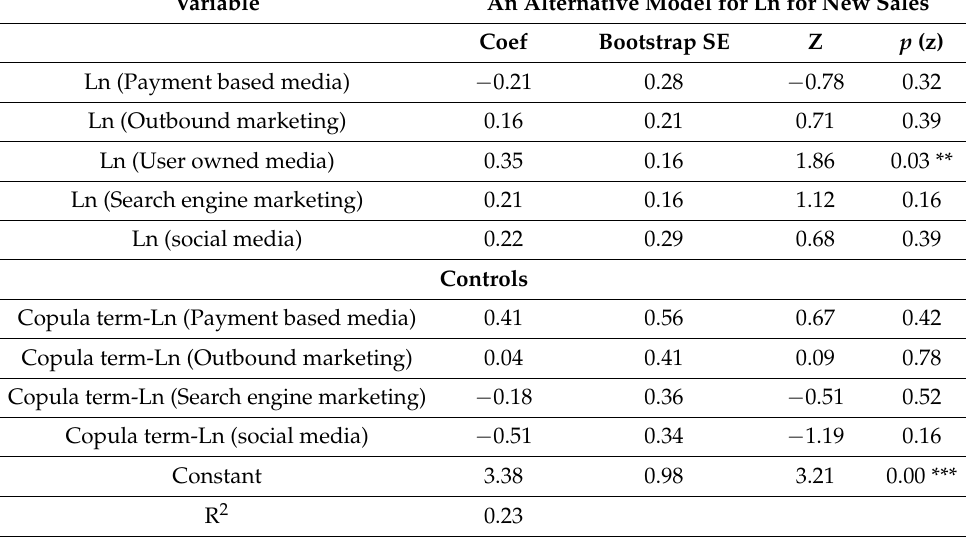
Table 5. Gaussian Copula model